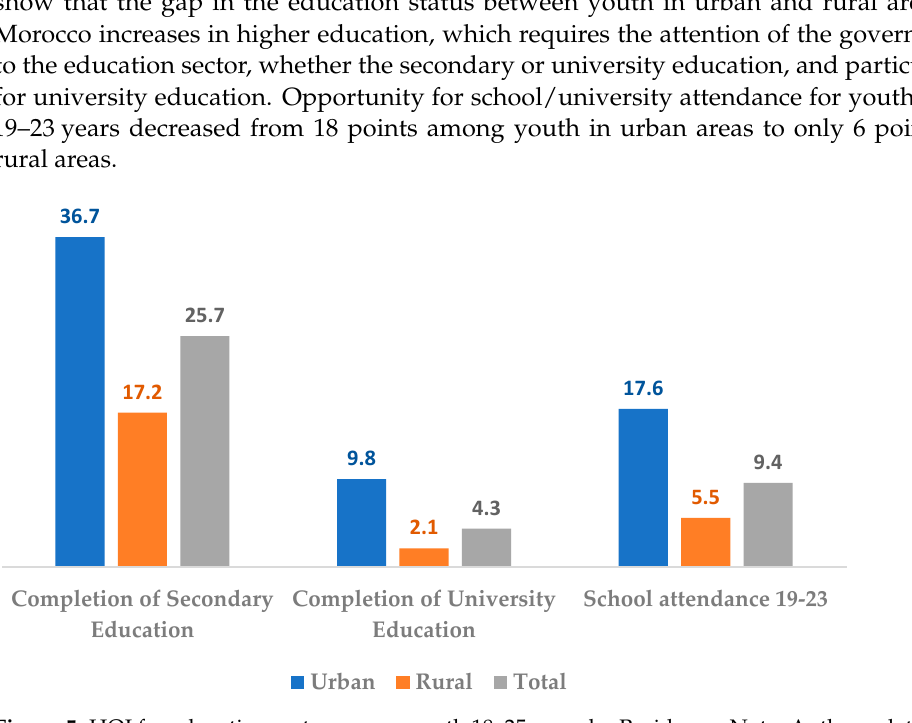
Figure 5. HOI for education sector among youth 18–25 years by Residence. Note: Authors, data from HCP open data (www.hcp.ma) (accessed on 1 April 2022).